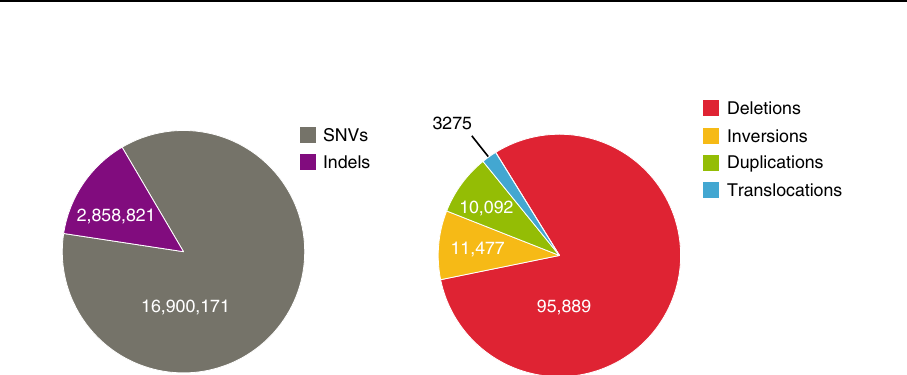
Fig. 1 Number of various genetic variant types identi fi ed in the Egyptian cohort. Left: The number of single nucleotide variants (SNVs) and small insertions and deletions (indels). Right: The number of structural variant (SV) calls: deletions, inversions, duplications and translocations. In addition, 408 insertions have been